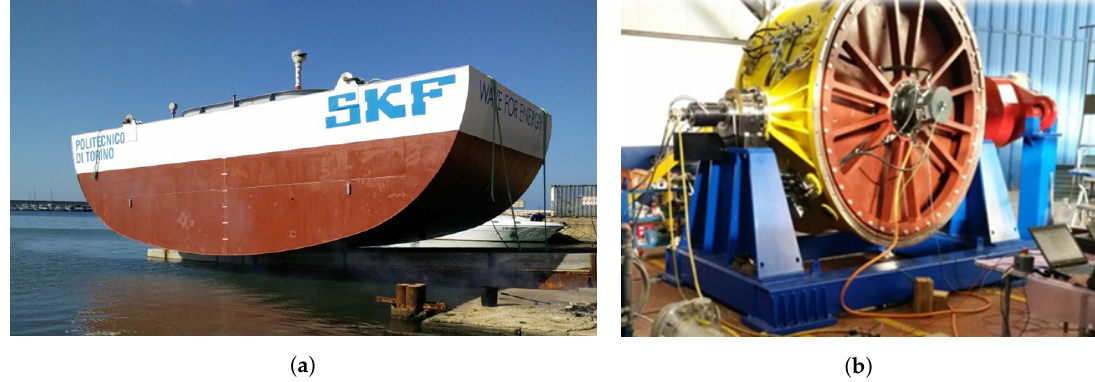
Figure 1. ISWEC device installed in Pantelleria island (Sicily, Italy): ( a ) ISWEC Pantelleria hull; ( b ) ISWEC Pantelleria